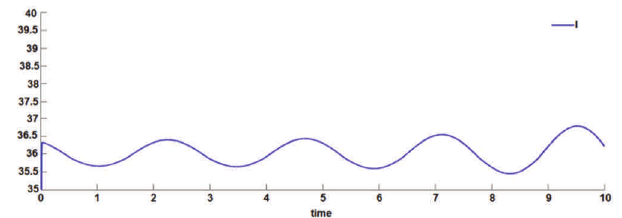
Fig. 7. Starting current characterisation for a four-cylinder